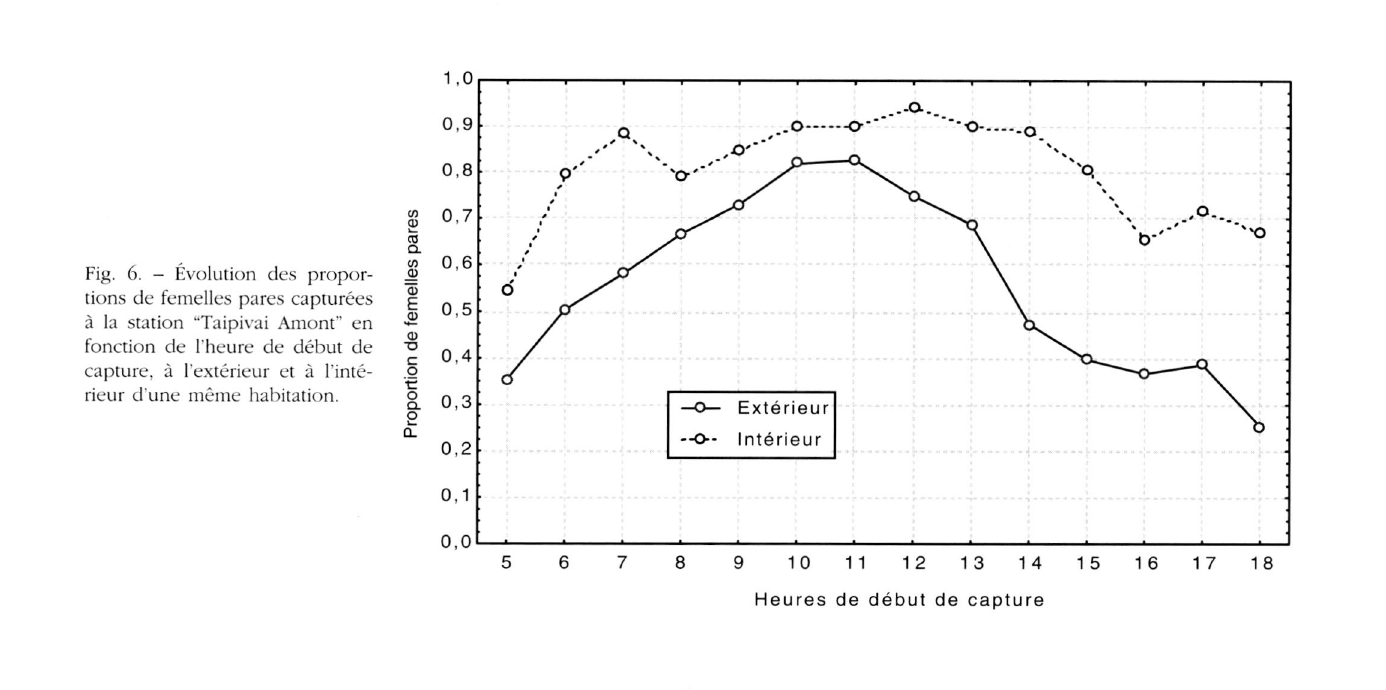
Fig. 6. - Évolution des propor tions de femelles pares